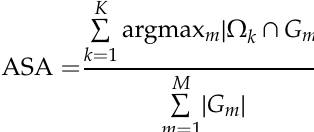
Figure 8. Comparison of runtime in milliseconds. ( a ) Time required for superpixels of increasing number in BSDS500; ( b ) time required for size-fixed superpixels of increasing size in multiple resolution image sets; ( c ) time required for number-fixed superpixels of increasing size in multiple resolution image sets. Green boxes show the local details of curves in ( b ) and ( c ).